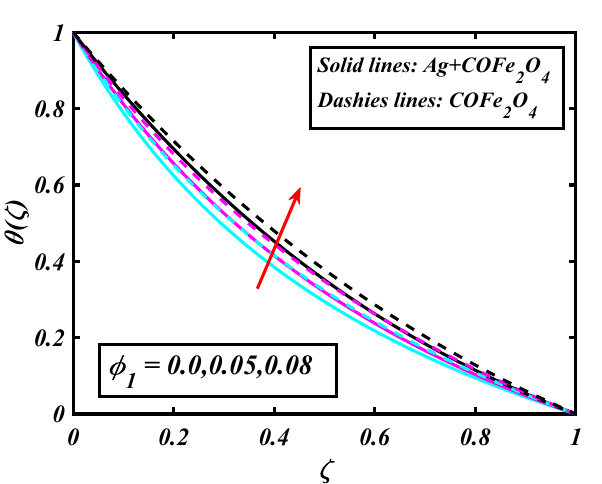
Figure 9. Demonstration of φ 1 through θ(ζ) .